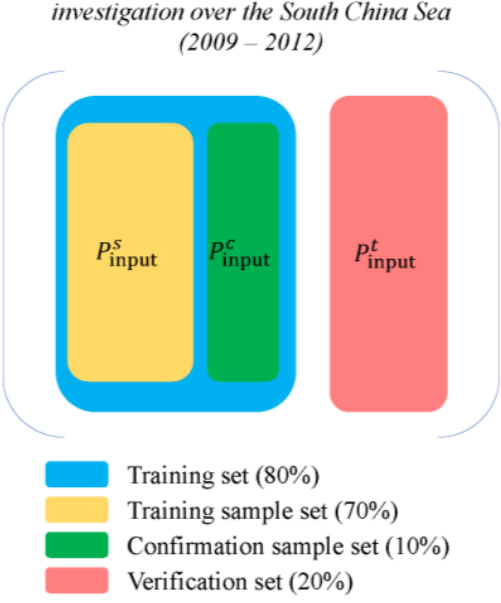
Figure 13. Division of the measured data.